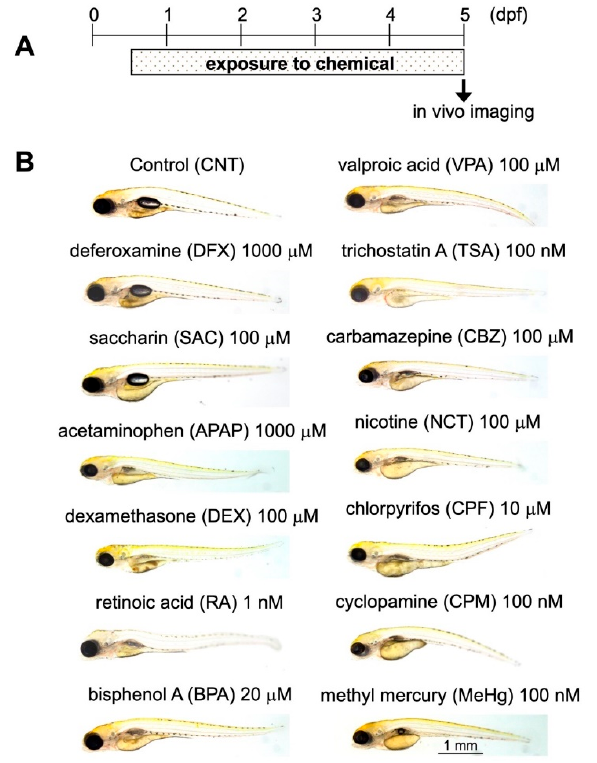
Figure 3. Bright-field images of triple-Tg zebrafish exposed to the maximum tolerable concentrations of chemicals during early development. ( A ) Experimental protocol. ( B ) Triple-Tg zebrafish were treated with the indicated chemicals at their maximum tolerable concentrations from 12 hpf to 5 dpf. The